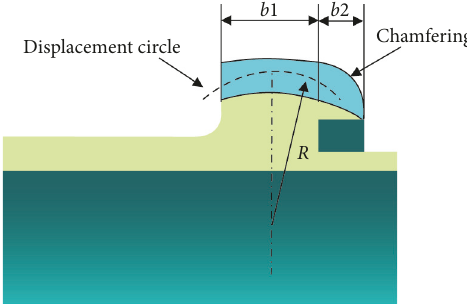
Figure 3: Three-dimensional half-cut view of drum tooth disk (partial). R , radius of displacement circle; b1, width of drum tooth section; b2, width of chamfered